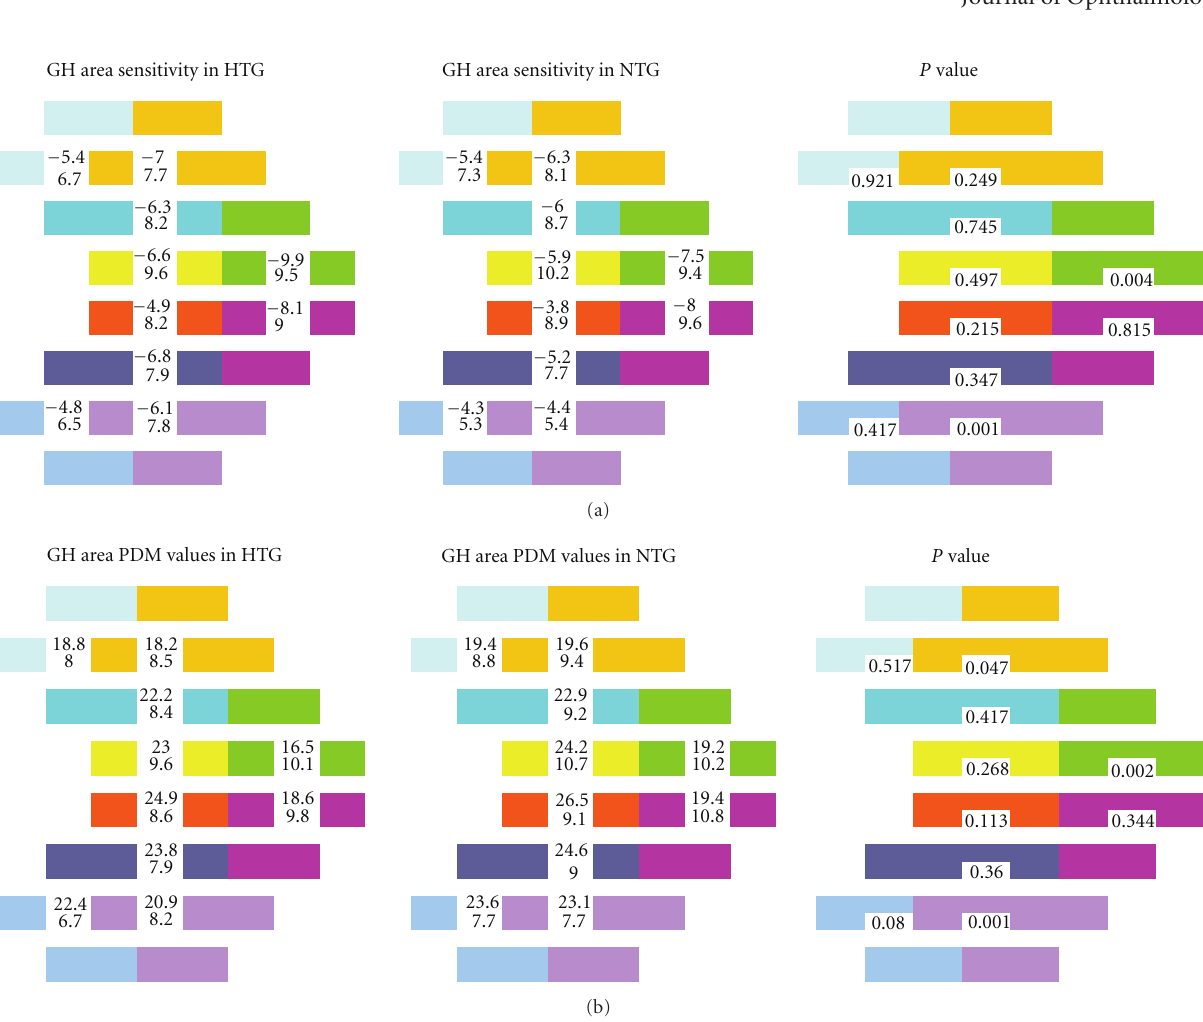
Figure 2: (a) Comparison ( P value) of the sensitivity values (mean and standard deviation) of the 10 glaucoma hemifield test (GHT) areas between HTG and NTG. The di ff erent colours represent the di ff erent areas used by the GHT. (b) Comparison ( P value) of the pattern deviation map (PDM) values (mean and standard deviation) of the 10 GHT areas between HTG and NTG. The di ff erent colours represent the di ff erent areas used by the